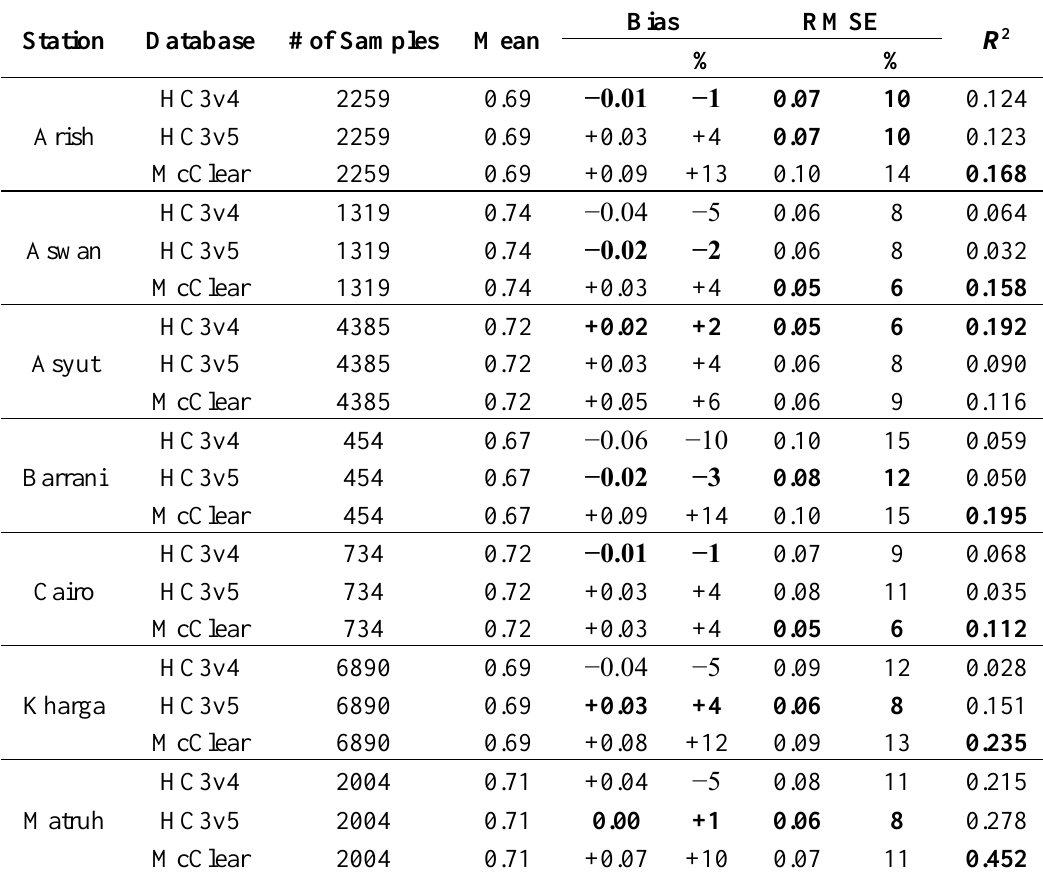
Table 3. Validation of the clearness index KT under cloud-free conditions, the best values for each station are in bold.